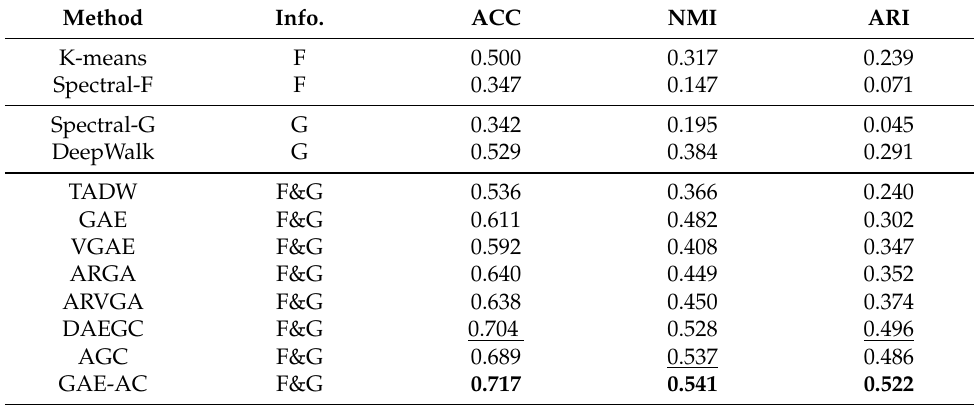
Table 2. Node Clustering Results on Cora Dataset.